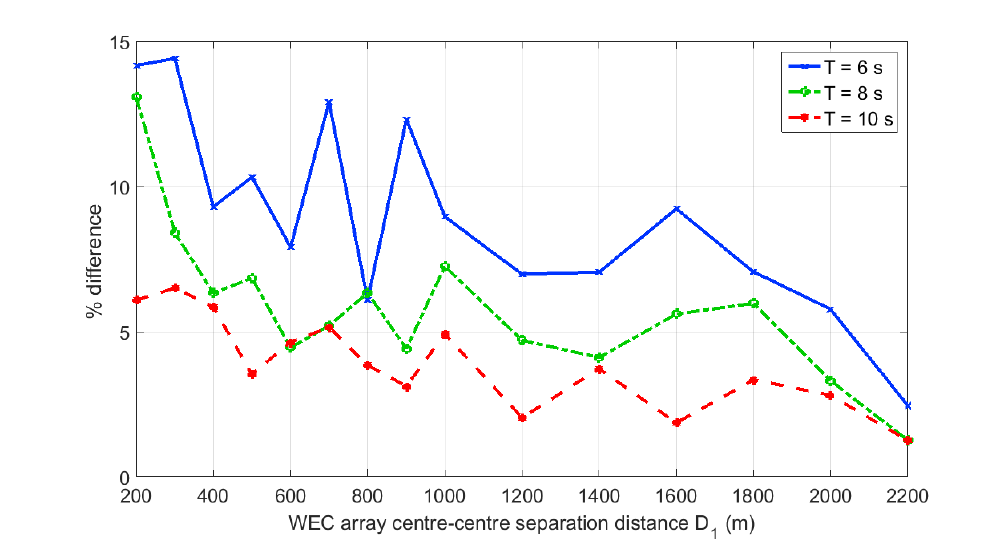
Figure 13. Percent difference between P farm of two WEC arrays separated by interarray distance D 1 and 2 × P array for irregular waves of T p = 6 s ( a ) T p = 8 s ( b ) and T p = 10 s ( c ) for 0 ◦ (solid line), 22.5 ◦ (dash-dot line), and 45 ◦ (dashed